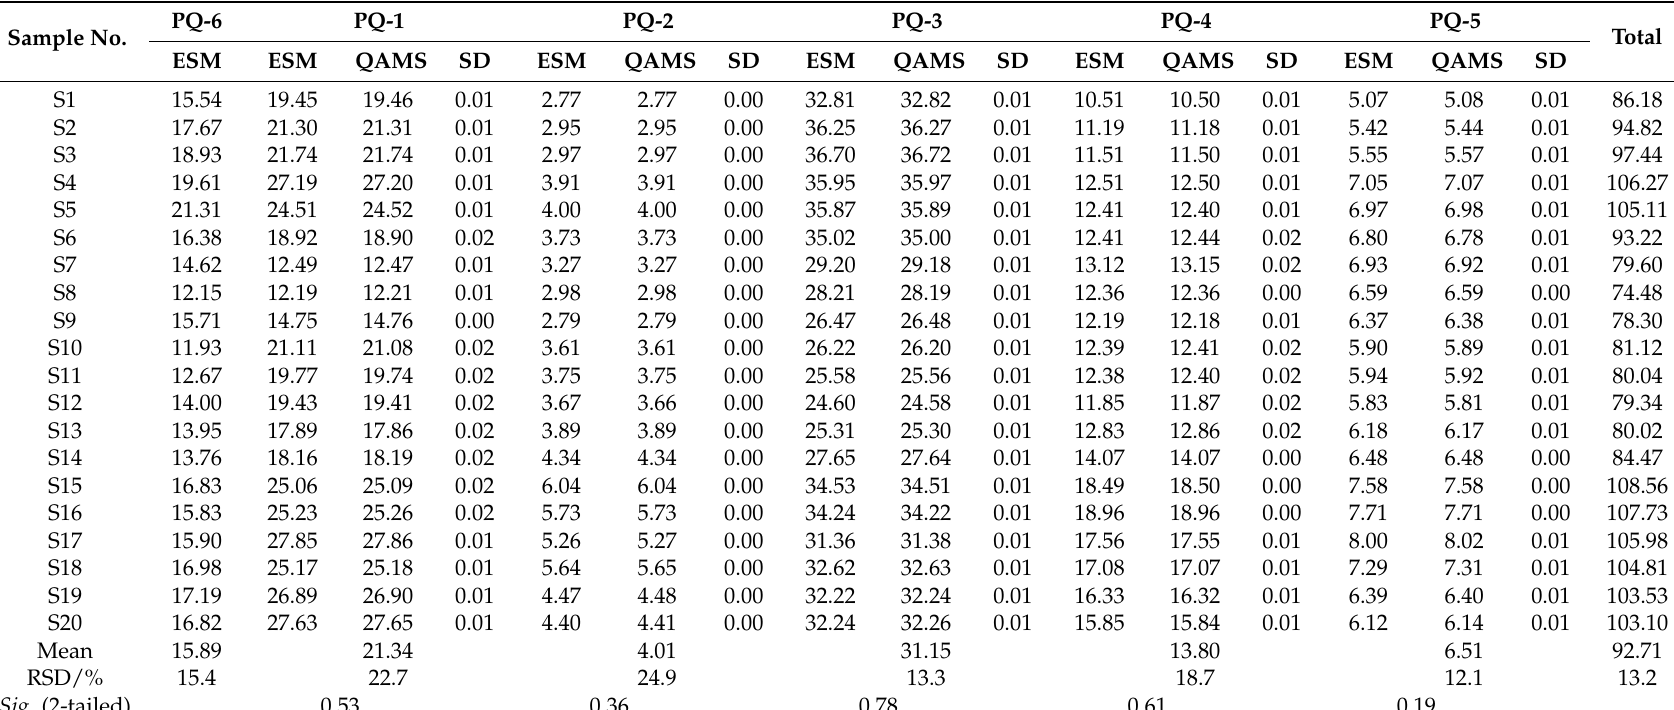
Table 5. Contents of the six analytes in KMI samples determined by ESM and QAMS methods ( µ g · mL − 1 ) 1 .